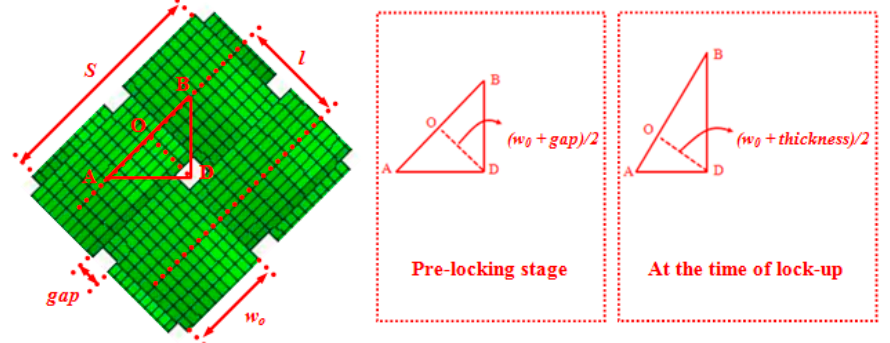
Figure 3. A PWCP representative element at the beginning of shear deformation.